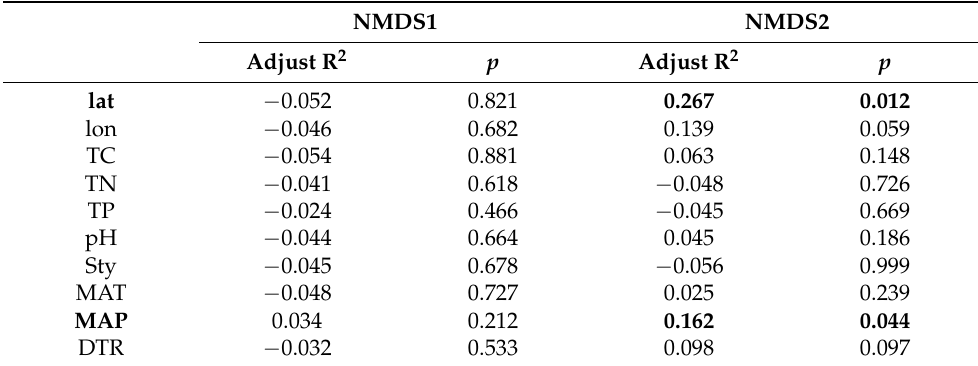
Figure 5. ( A ) β NRI, β NTI, and RC bray values are depicted in box plots. ( B ) Relationships between wetland plants communities (taxonomic Bray–Curtis similarity) and the Euclidean distance of geographic distance, environmental factors. The Mantel test was used to examine the correlations between the pairwise Bray–Curtis similarity and pairwise differences in geographic distance/environmental factors. ( C ) Variation partitioning showing the contribution of spatial factors (geo) and environmental variables (env) to the variation of taxonomic beta-diversity. Table 1. Spearman correlation coefficients between the geospatial/environmental predictors and the first two axes of